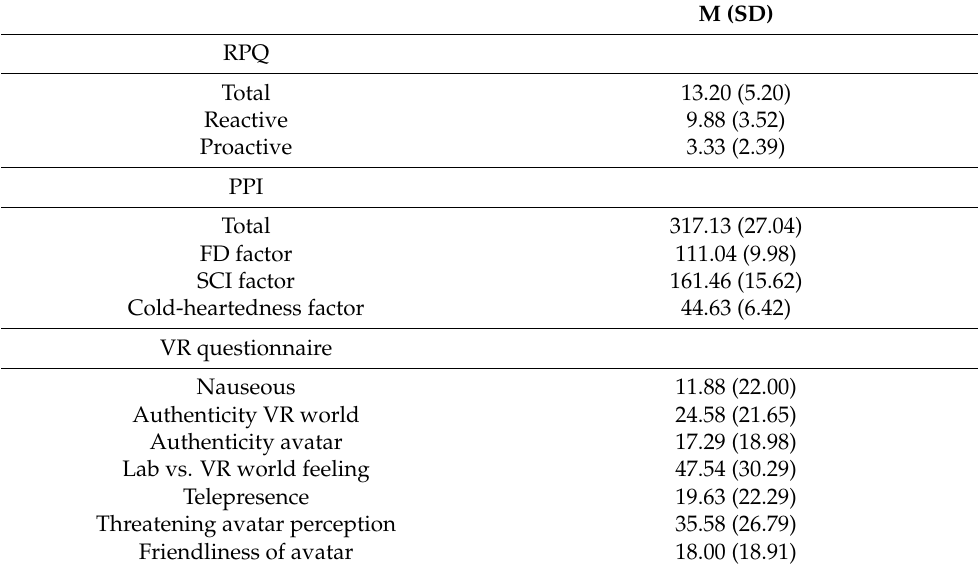
Table 1. Study 1: Description of study variables, N =